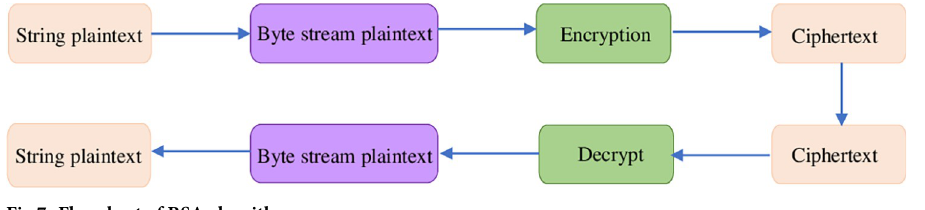
Fig 7. Flowchart of RSA